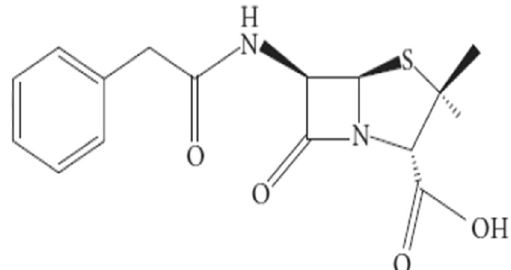
Fig. 1 Chemical structure of